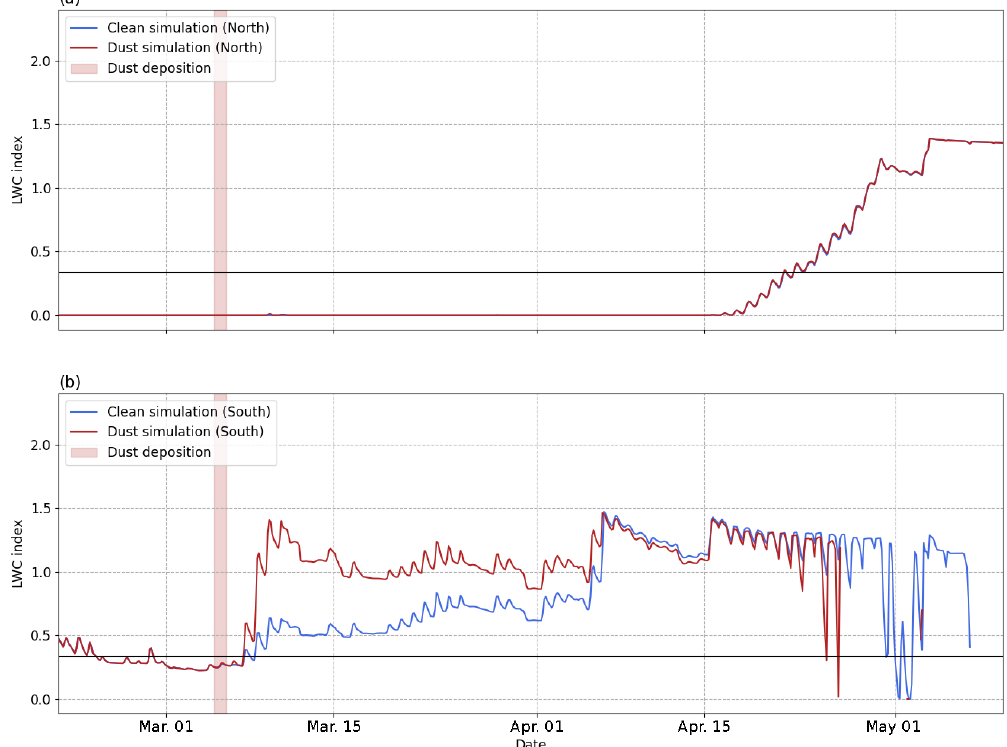
Figure A1. Same representation as Fig. 8 for another member of the ensemble (member 20) featuring a LWC index already high at the deposition